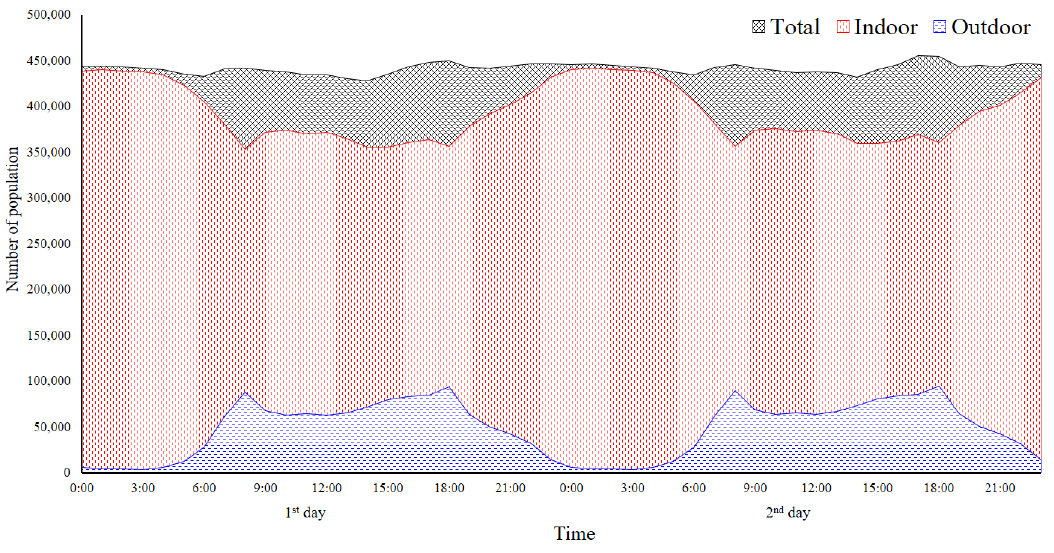
Figure 7. Temporal variation of the total number of people in Guro-gu.